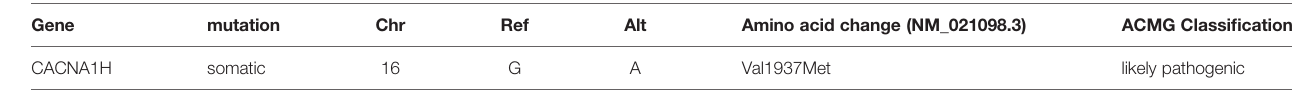
TABLE 1 | Novel CaV3.2 calcium channel mutation identi fi ed in uPA by next-generation sequencing.